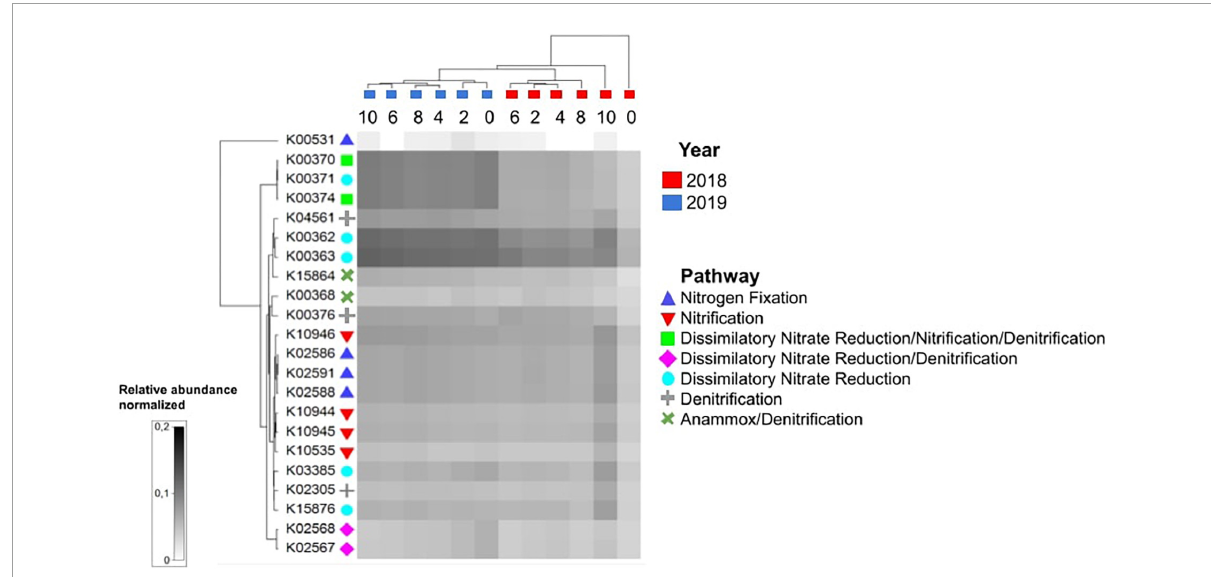
FIGURE5 PICRUSt2 functional prediction analysis for nitrogen cycling functions across different temporal and spatial scales. During stratification, KOs related to nitrogen metabolism were more prevalent in the hypolimnion than in the other strata.